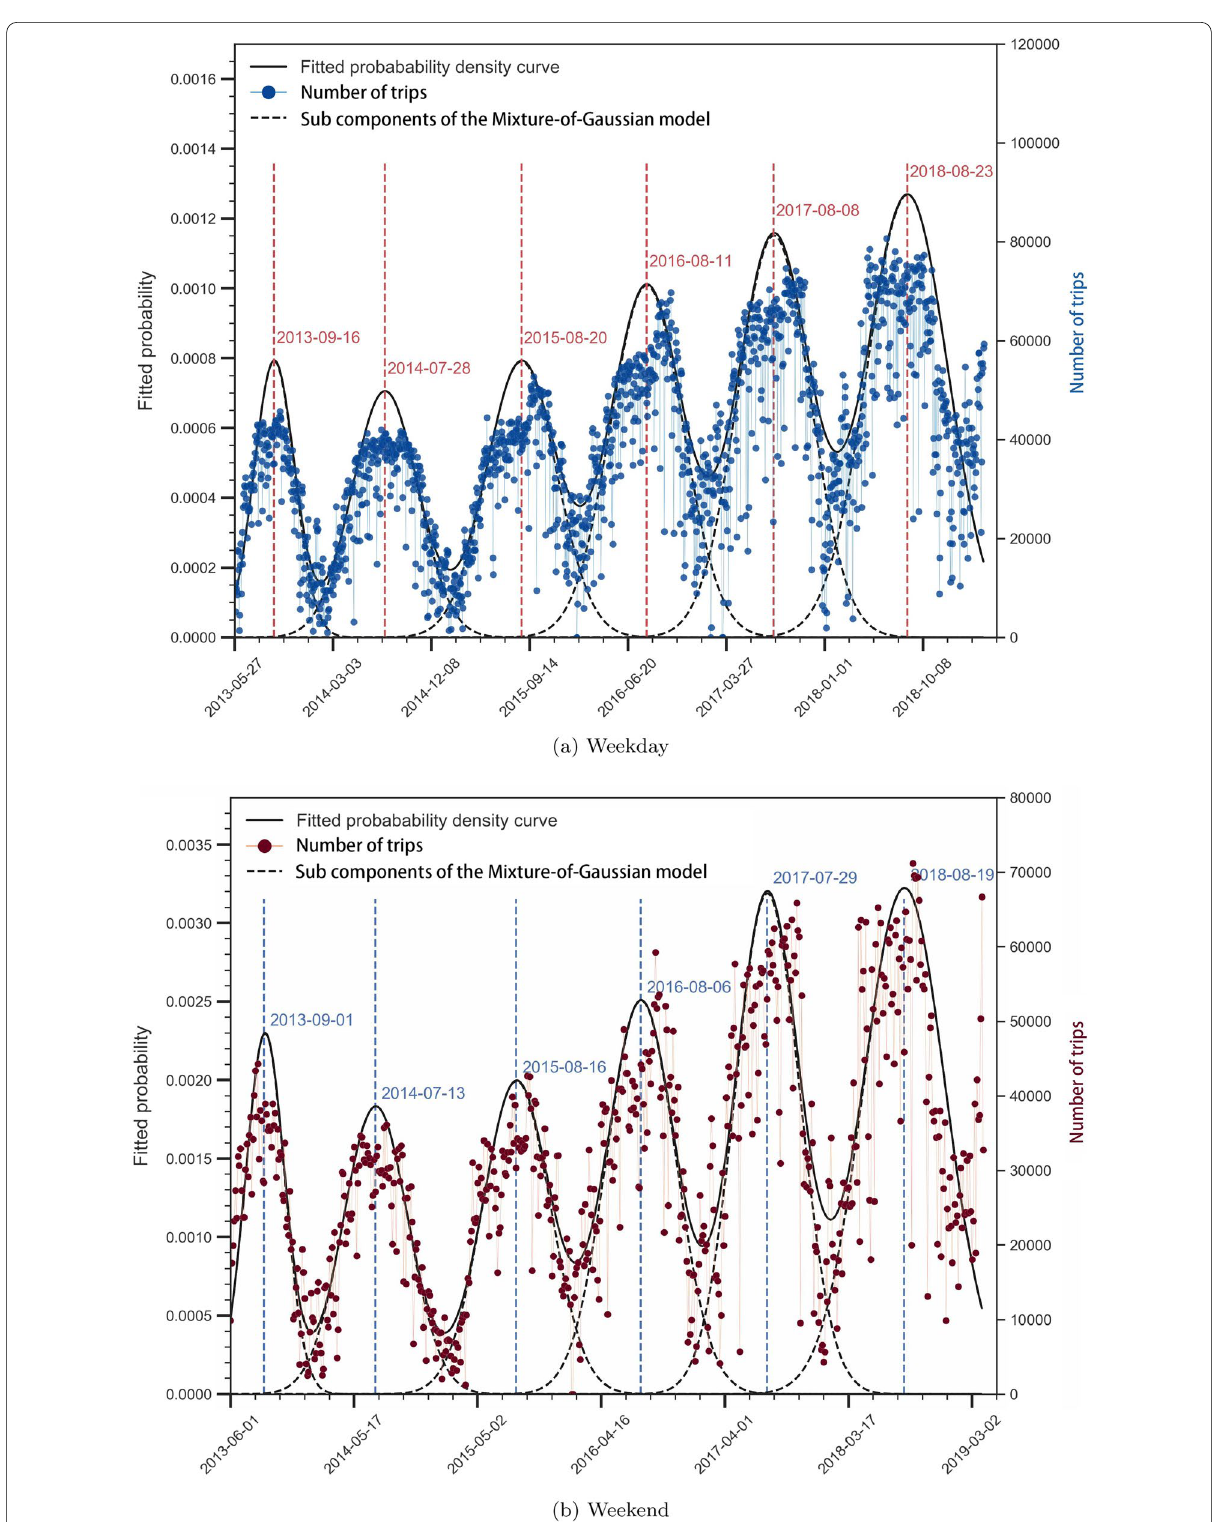
Fig. 8 The growth periodic of New York’s bike-share system modeled by a Mixture-of-Gaussian